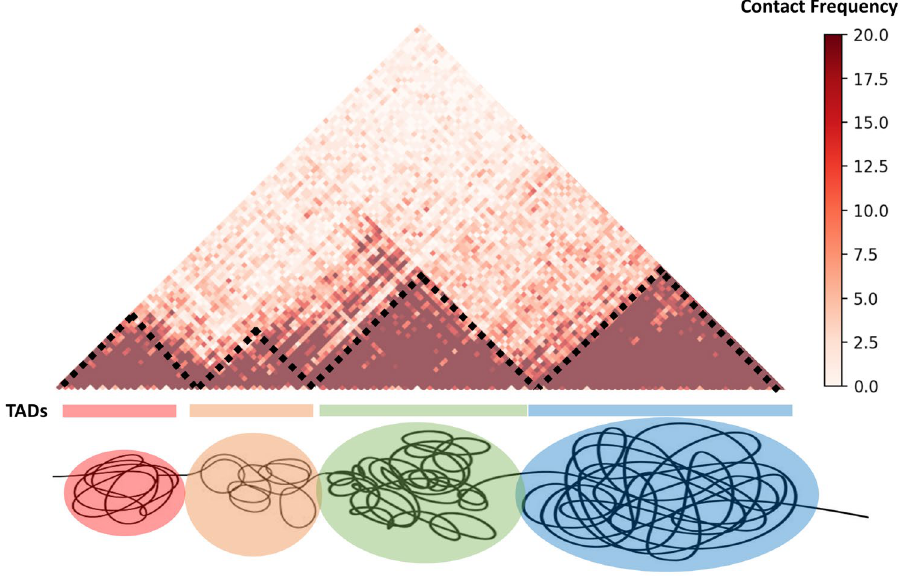
Figure 8. An illustration of topologically associating domains (TADs) for Hi-C data. The TAD is defined to be square region along the diagonal Hi-C maps with large contact values and a size of about 200 kilobases (Kb) to 2 megabases (Mb). The black dash lines mark the boundaries of TADs. Note that it is not always easy to clearly identify these “square regions”. For instance, it is also reasonable to believe that the two TADs in the middle region can be aggregated into one